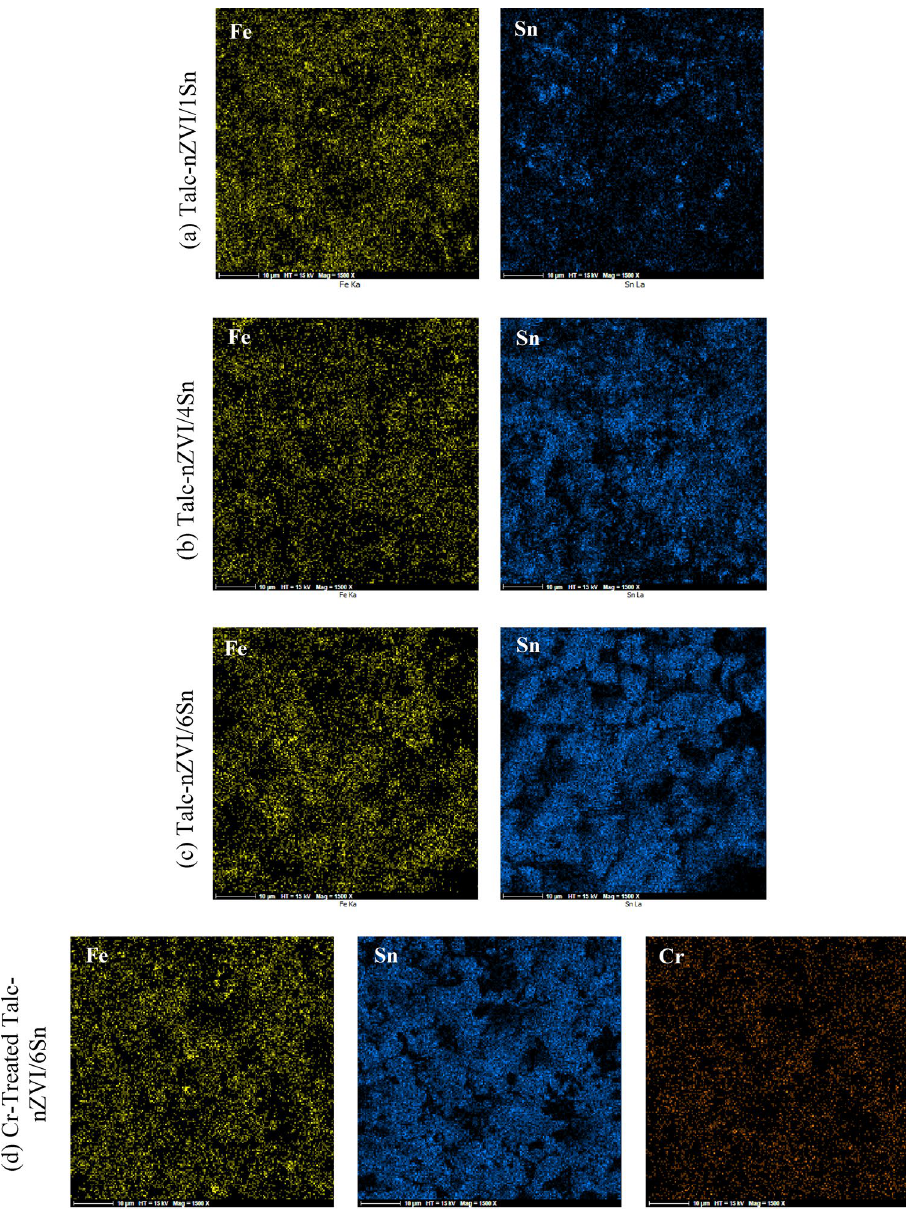
Figure 2. EDS mapping of Fe, Sn, and Cr in ( a ) fresh Talc-nZVI/1Sn ( b ) fresh Talc-nZVI/4Sn ( c ) fresh Talc- nZVI/6Sn and (d) Cr-treated